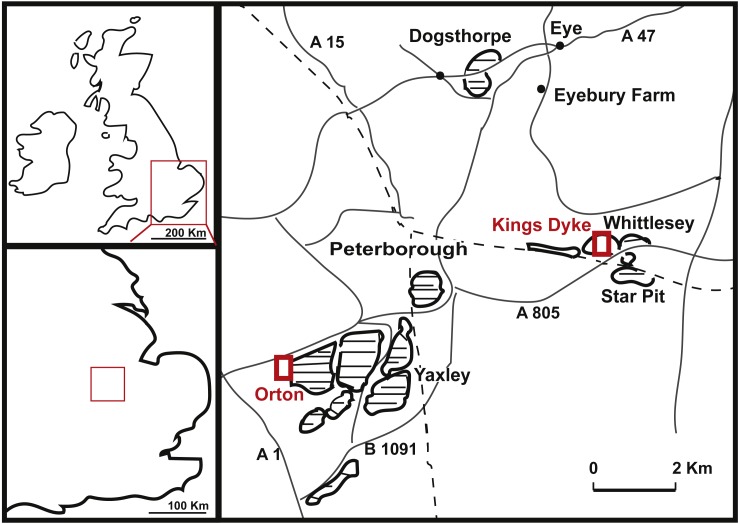
Geographical position of King’s Dyke, Orton and Star Pit, Whittlesey, UK.(adapted after  Hudson & Martill (1994), with notes from  Liston (2006)).